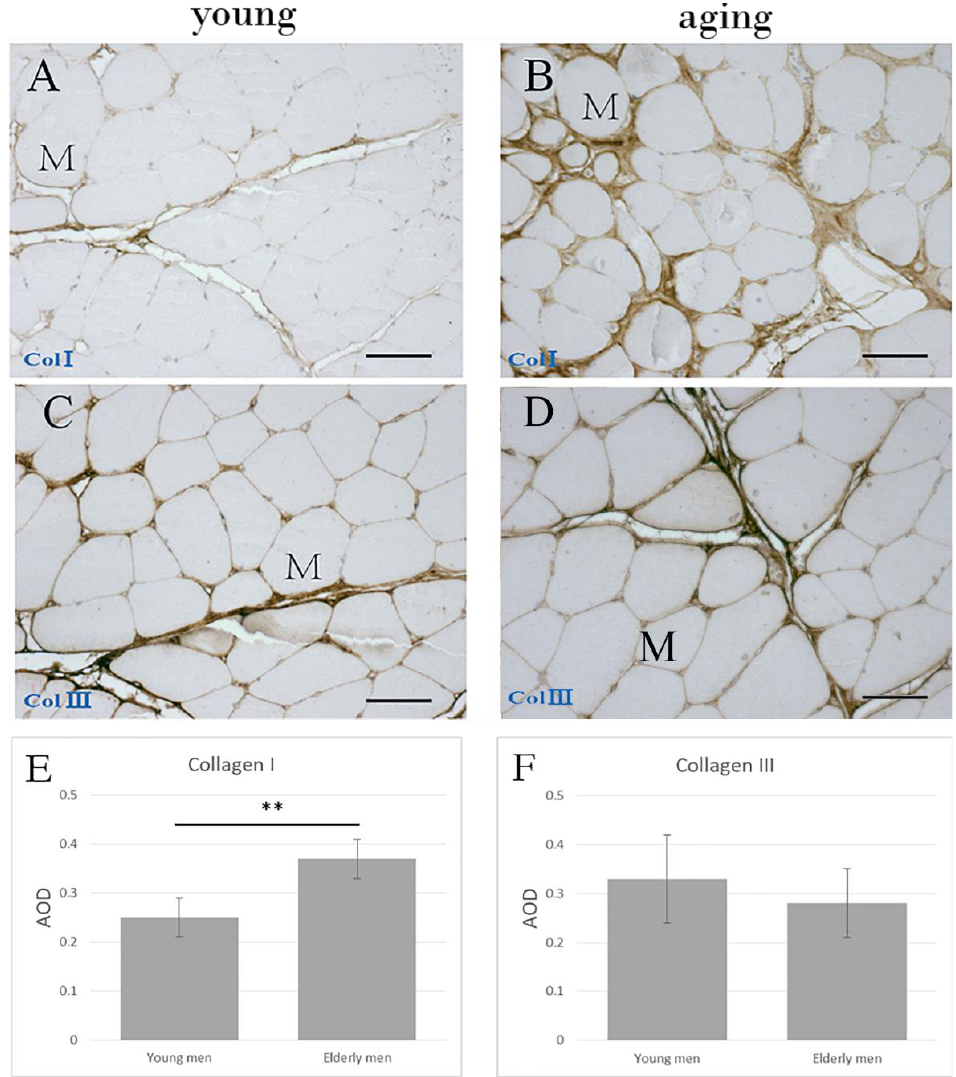
Figure 4. Immunohistochemical staining of collagen type I ( A , C ) and collagen type III ( B , D ) in the perimysium and endomysium of human muscle samples from an 18 year old ( A , C ) and an 83 year old ( B , D ) human patient. ( E , F ) show the AOD of the collagen I and collagen III, respectively, in young and elderly men. ** p < 0.001. M = muscle cell. Scale bars: 50 μm.